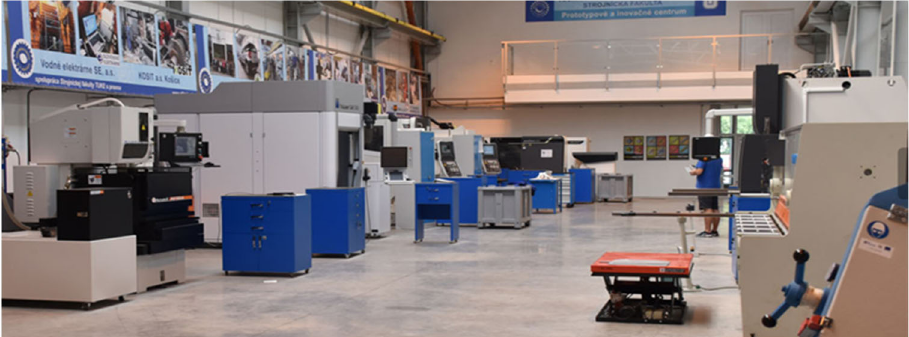
Figure 10. A view of the technological part of the production environment of the innovation center.